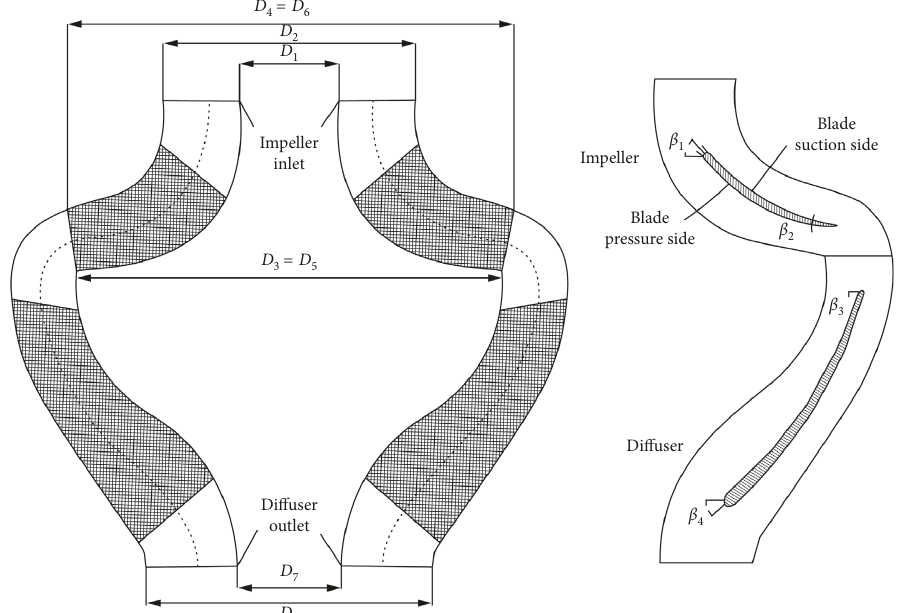
Figure 2: 2D illustration of the electric lifting pump stage.